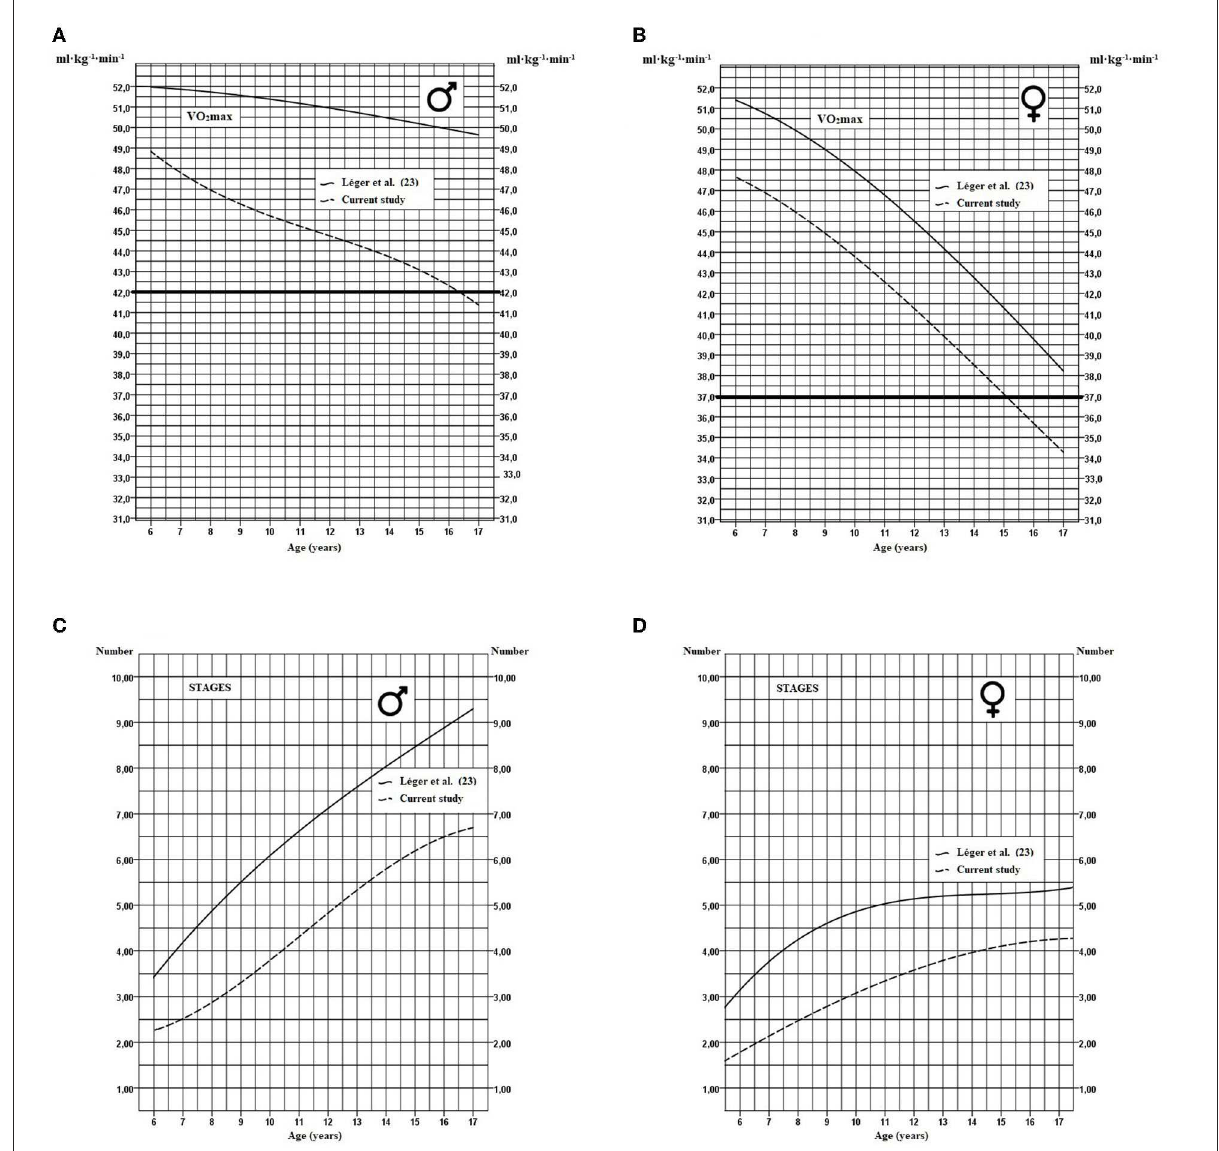
FIGURE3 Modeling of the secular trend curves for median VO 2 max and for the number of stages completed between 1982 and 2017 for 6 to 17 yrs boys (A, C) and girls (B, D) . The thick horizontal line represents the critical cutoff health